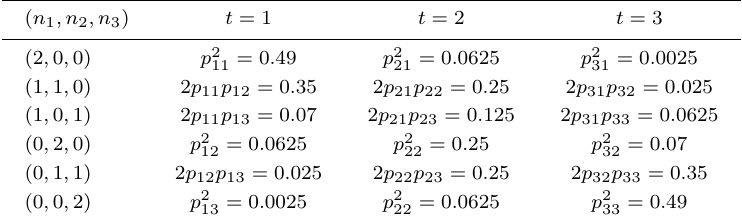
Table 2. Conditional probability distributions of the attribute estimates when probability matrix is P 1 and n = 2 .